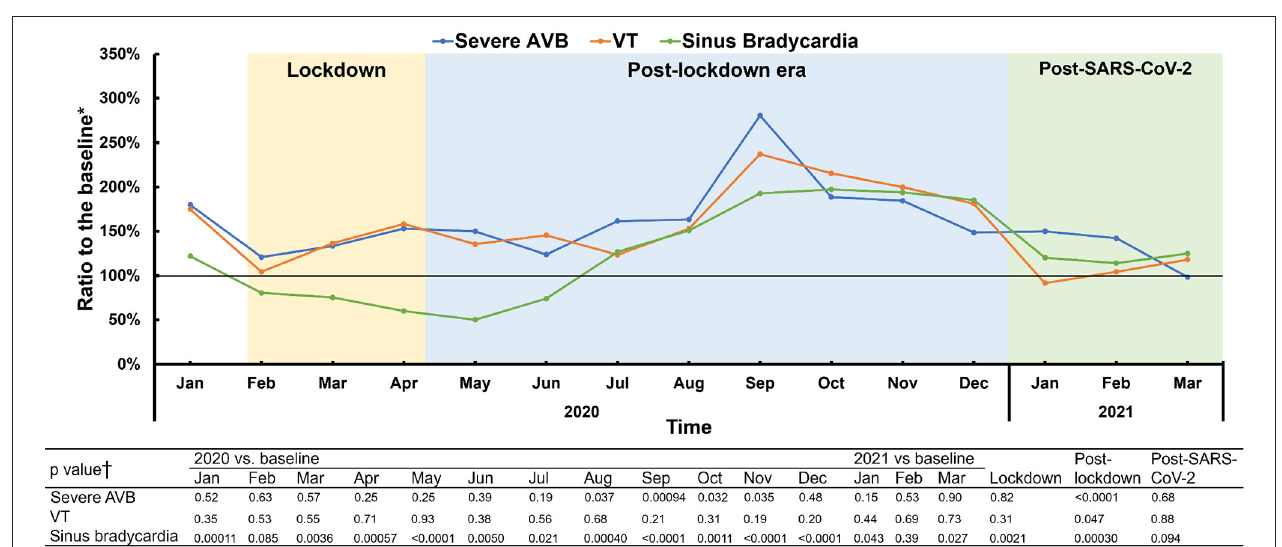
FIGURE 4 | Medical visits to academic hospitals and community clinics. *Ratio to the average number of medical visits between 2018 and 2019.